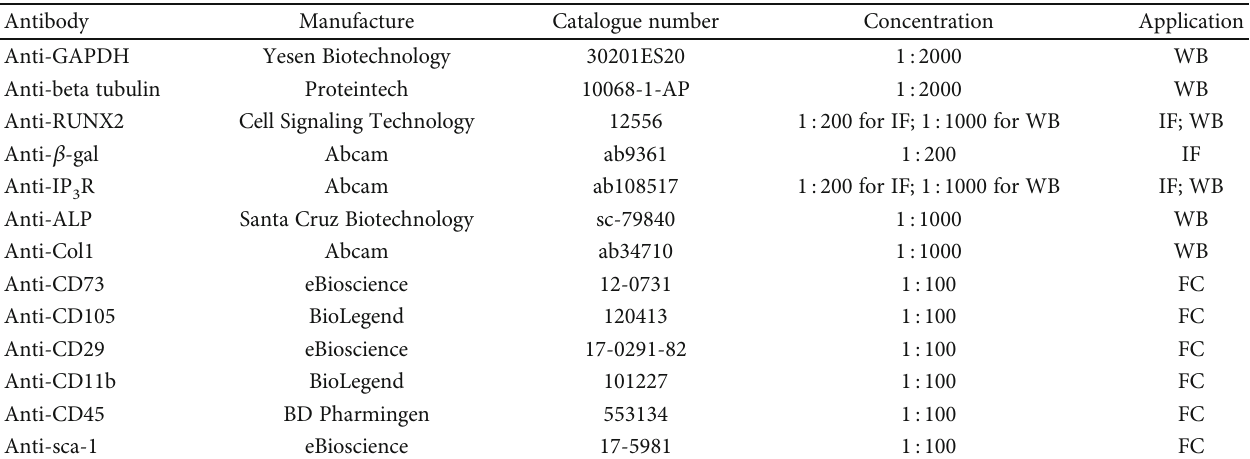
Figure 3: Mechanical stretching induces Gli1 + cell increases and regulates JBMMSC osteogenesis via IP R-mediated intracellular calcium 3 increases. (a) Experimental procedure: Gli1-mT/mG mice were treated with tamoxifen for 4 consecutive days and were sacri fi ced after 7 days to isolate JBMMSCs. (b) Flow cytometry analysis of the proportion of Gli1 + cells in JBMMSCs; the stretch-treated group showed an increase in Gli1 + cells; n = 3 . (c) The proportion of Gli1 + cells was higher in the stretch group. P < 0 : 005 ; n = 3 . (d) Alkaline phosphatase (ALP) activity of JBMMSCs subjected to mechanical stretching was higher after osteogenic induction for seven days. Mineralized nodules formed by JBMSCs were detected using alizarin red staining after osteogenic induction for 14 days. (e) The abundance of mineralized nodules in the stretch group was higher. ∗ P < 0 : 05 ; n = 3 . (f) Western blot analysis of ALP, RUNX2, Col1, and IP R protein expression 3 levels in JBMSCs which after mechanical stretching were upregulated, compared with control cells; n = 3 . (g) RT-qPCR showed upregulation of ALP, RUNX2, and Col1 RNA expression in JBMSCs after mechanical stretching, compared with control cells. ∗∗ P < 0 : 01 ; ns P > 0 : 05 ; n = 3 . (h) RT-qPCR showed upregulation of IP R1, IP R2, and IP R3 RNA expression in JBMSCs after mechanical stretching, 3 3 3 compared with control cells. ∗ P < 0 : 05 ; ns P > 0 : 05 ; n = 3 . (i) Intracellular calcium concentration visualized at mean fl uorescence intensity was increased in the stretch group. ∗∗∗ P < 0 : 005 ; n = 3 Table 2: Antibodies used in this research.